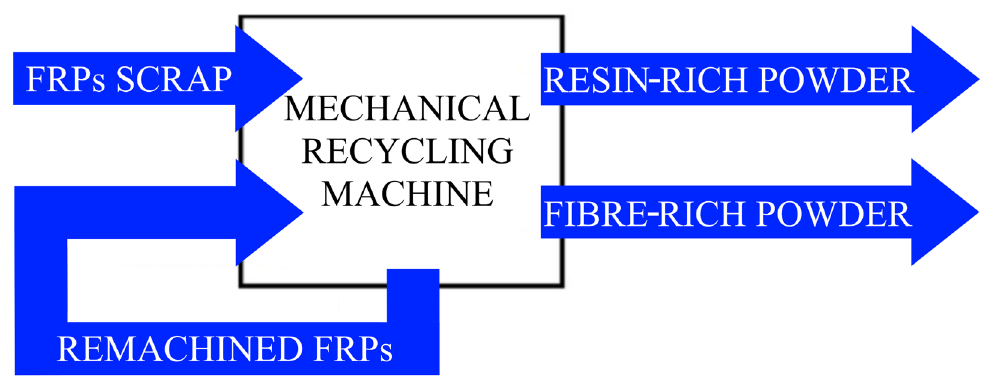
Figure 12. Schematisation of a typical mechanical recycling process.